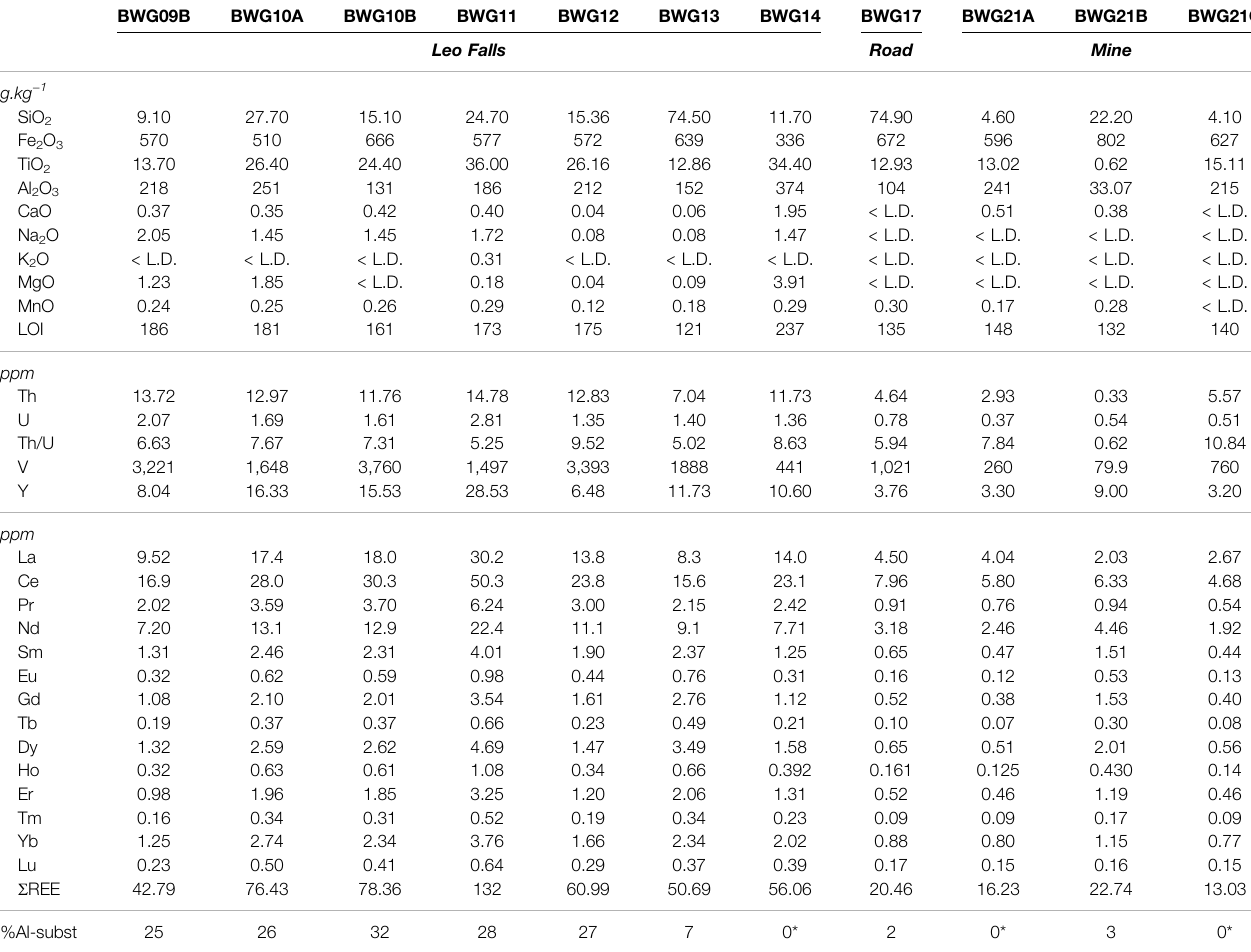
TABLE 2 | Chemical concentration of the bulk samples from the 3 sites and calculated Al-substitution from XRD diagram according to Schulze (1984). < L.D. = under detection limit. *For calculated %Al-substitution, results that are negative are set to zero.